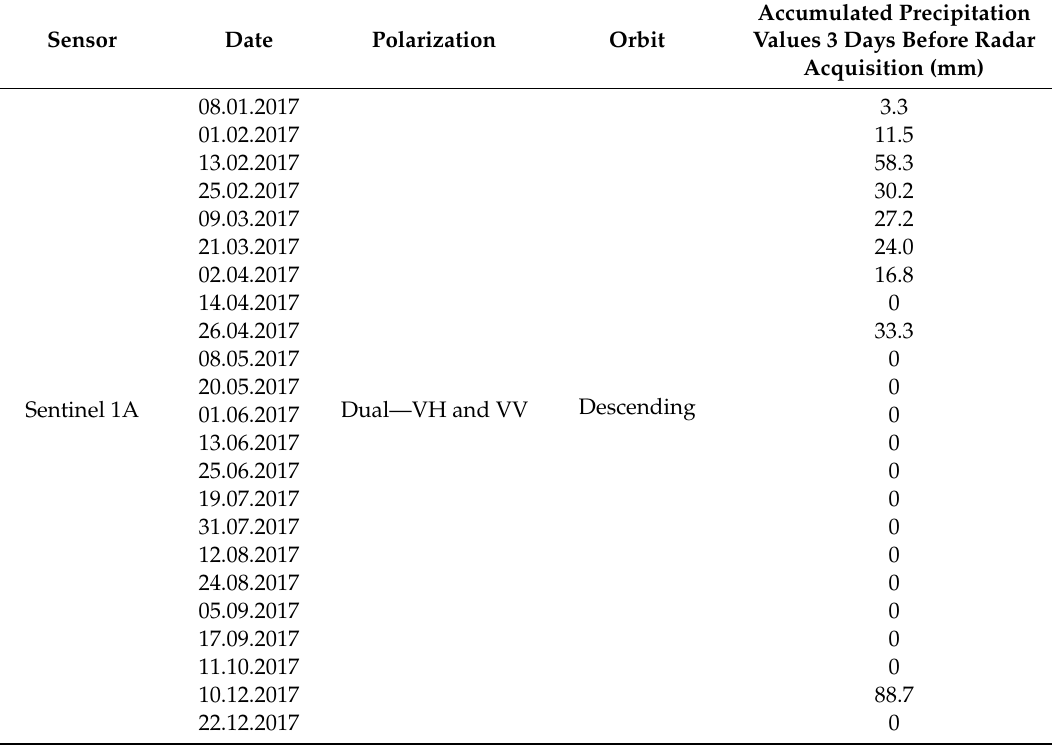
Table 1. Characteristics of the selected satellite images and the accumulated precipitation values three days before Radar acquisition.